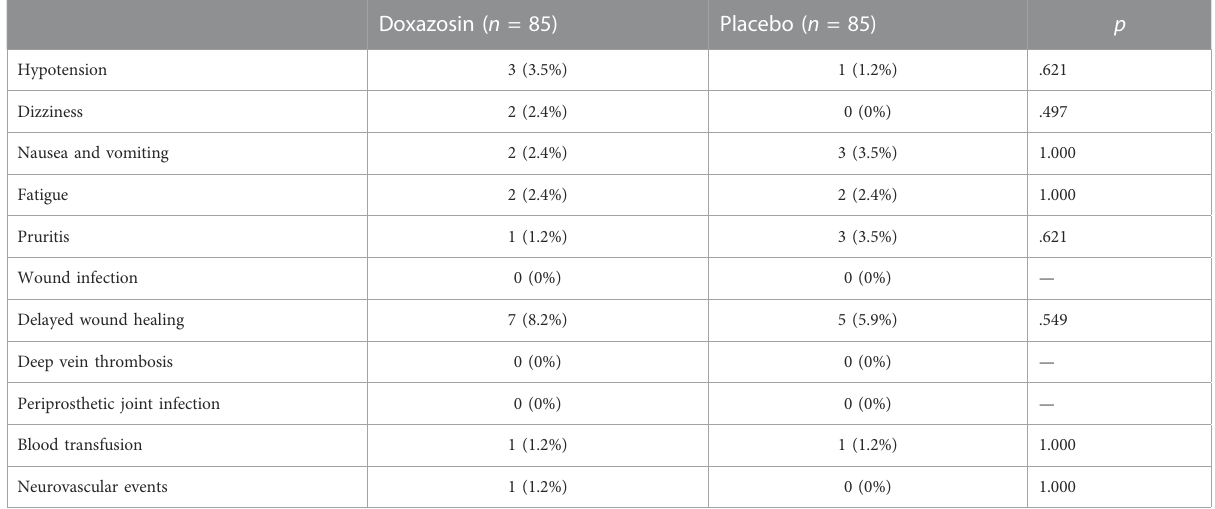
TABLE 3 Adverse